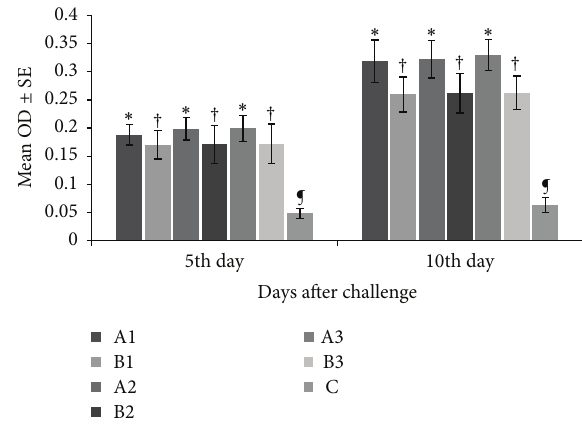
Figure 4: Serum antibody titers on day 5 and 10 after chal- lenge with Eimeria species (local isolates). A1 = Emblica officinalis derived tannins at 0.50 gm/Kg b. wt; B1 = commercial tannins at 0.50 gm/Kg b. wt; A2 = Emblica officinalis derived tannins at 0.75 gm/Kg b. wt; B2 = commercial tannins at 0.75 gm/Kg b. wt; A3 = Emblica officinalis derived tannins at 1.00 gm/Kg b. wt; B3 = commercial tannins at 1.00 gm/Kg b. wt; C = PBS-administered negative control. Bars sharing similar letters on each particular day are statistically nonsignificant ( 𝑃 > 0.05